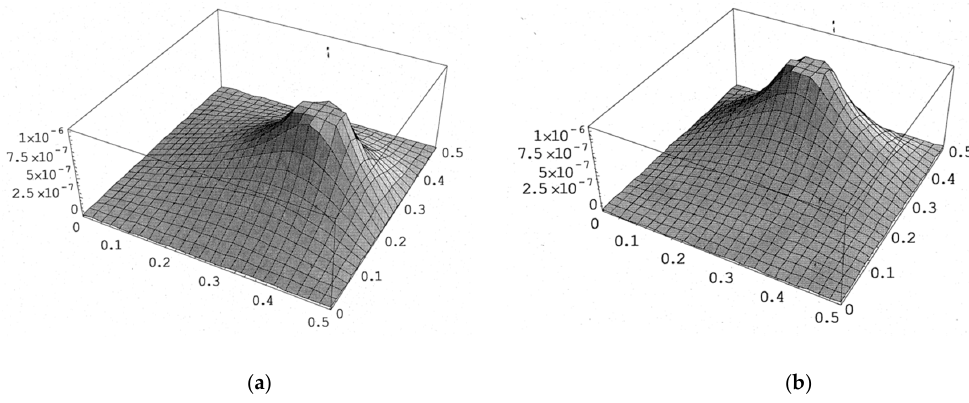
Figure 11. The deformed shape of the composite laminate plate with PZT actuator located at the right and top positions of the plate. (a) PZT actuator located at right of composite plate. (b) PZT actuator located at top of composite plate.